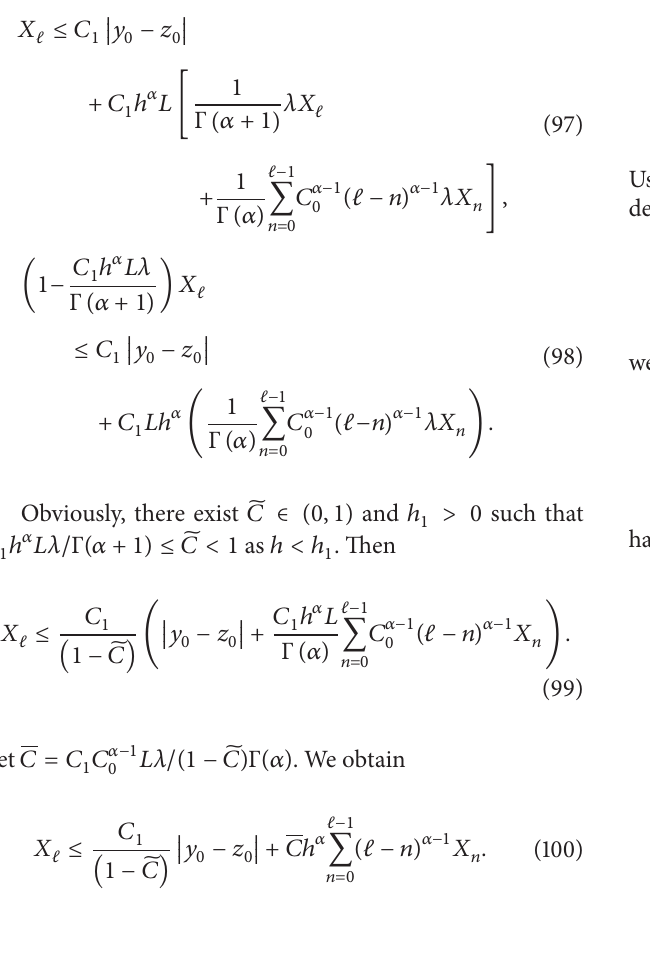
where 𝐶 1 = ‖𝐷 −1 (𝜙 1 , 𝜙 2 )‖/(1 − ‖𝐷 −1 (𝜙 1 , 𝜙 2 )𝐶(𝜙 1 , 𝜙 2 )‖) . By means of (94), we